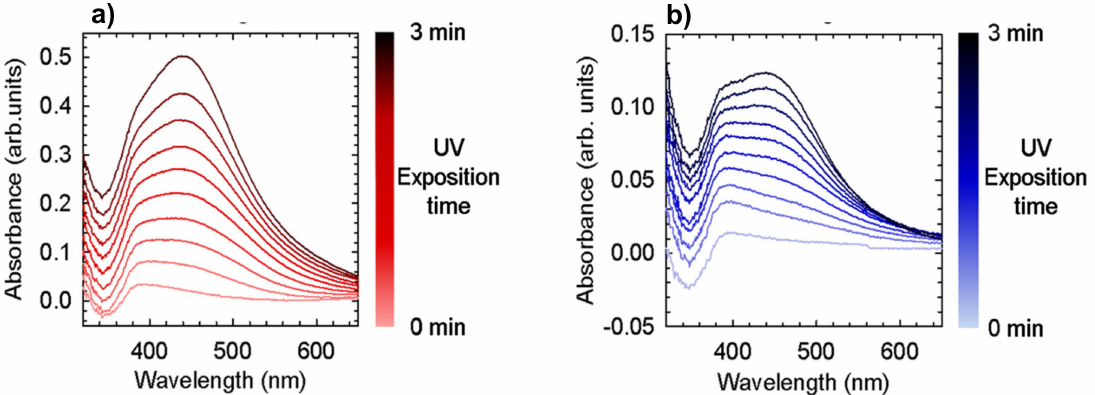
Figure 3. UV Absorption spectra as a function of exposure time to ultraviolet light (curves taken every 15 s of exposure) for two samples at di ff erent Ag precursor concentration, 50 mM red graph ( a ) and 25 mM blue graph ( b ).